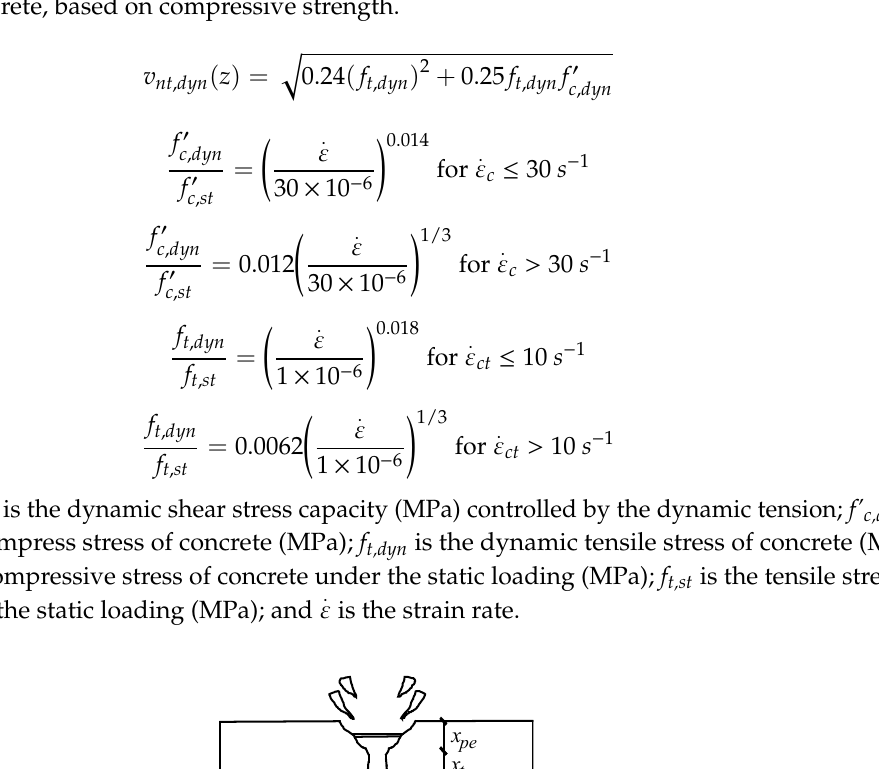
Figure 2. Stress flow on interface between scabbed concrete and slab.